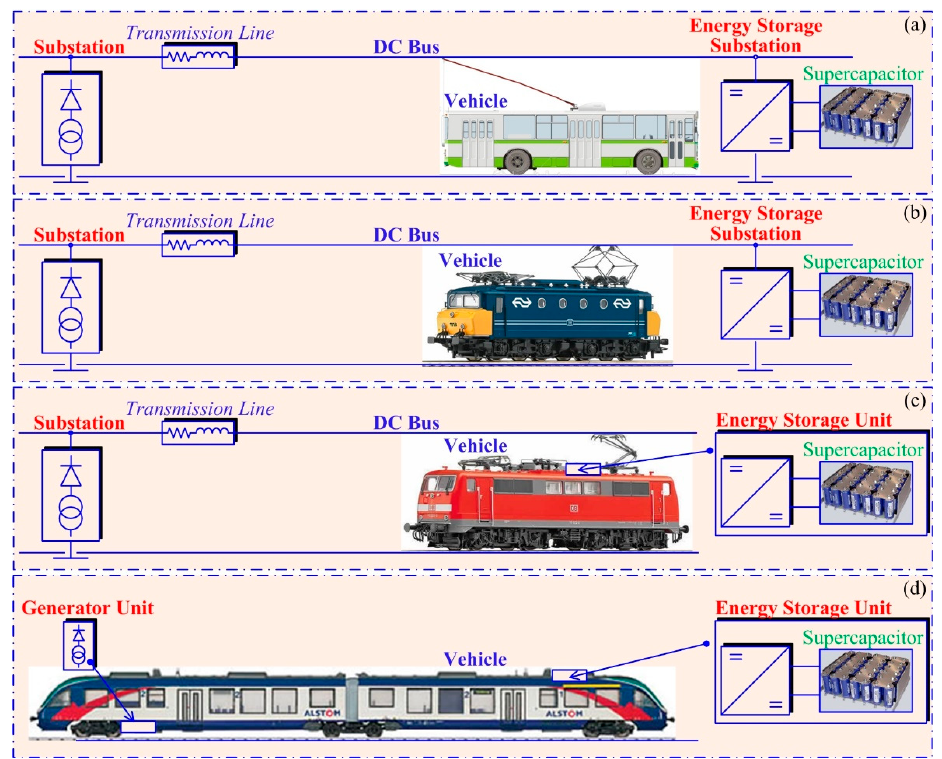
Figure 1. Energy storage network based on a supercapacitor (SC) module in public transportation applications: ( a ) trolley bus: substation; ( b ) tramway or train: substation; ( c ) tramway or train: onboard; and ( d ) diesel locomotive: